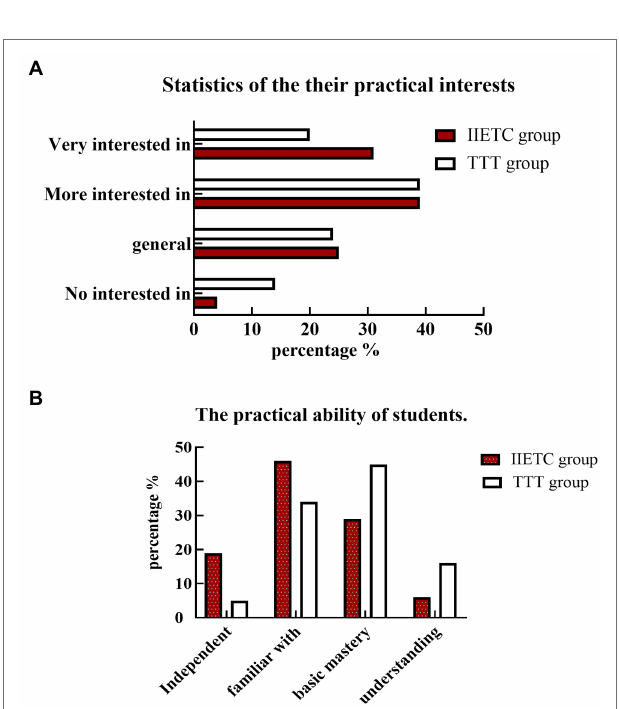
FIGURE 4 | Statistics on students’ psychological activities and practical ability. (A) Statistics on their practice interest; (B) statistics on students’ practical abilities.